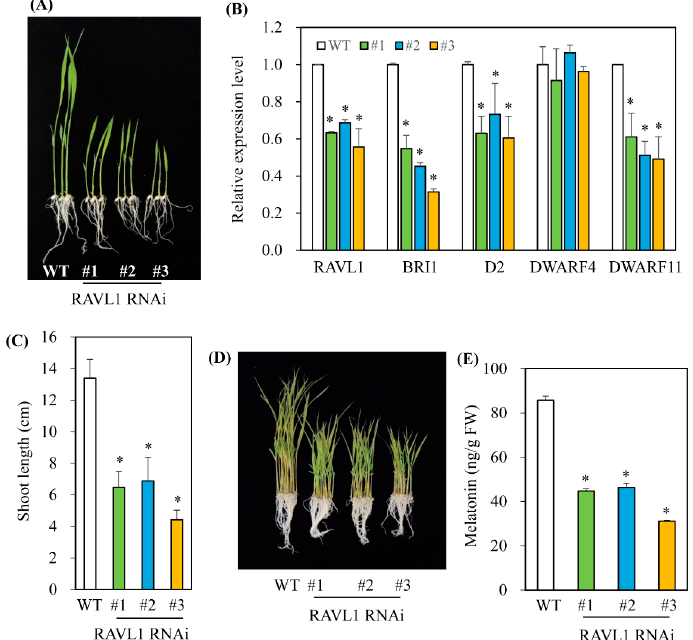
Figure 5. Generation of DWARF11 -suppressed transgenic rice plants. ( A ) Phenotypes of 7-day-old wild- type (WT) and DWARF11 RNAi transgenic (T 2 ) rice seedlings. ( B ) Shoot length measurement. ( C ) Results of qRT-PCR analyses of WT and transgenic (T 2 ) lines. ( D ) Phenotypes of 7-day-old rice seedlings after cadmium treatment. ( E ) Melatonin levels of WT and transgenic lines. The 7-day-old rice seedlings were challenged with 0.5 mM cadmium for 3 days for quantification of melatonin. Asterisks (*) indicate significant differences from the wild type ( p < 0.05), as determined by Tukey’s HSD post hoc tests.